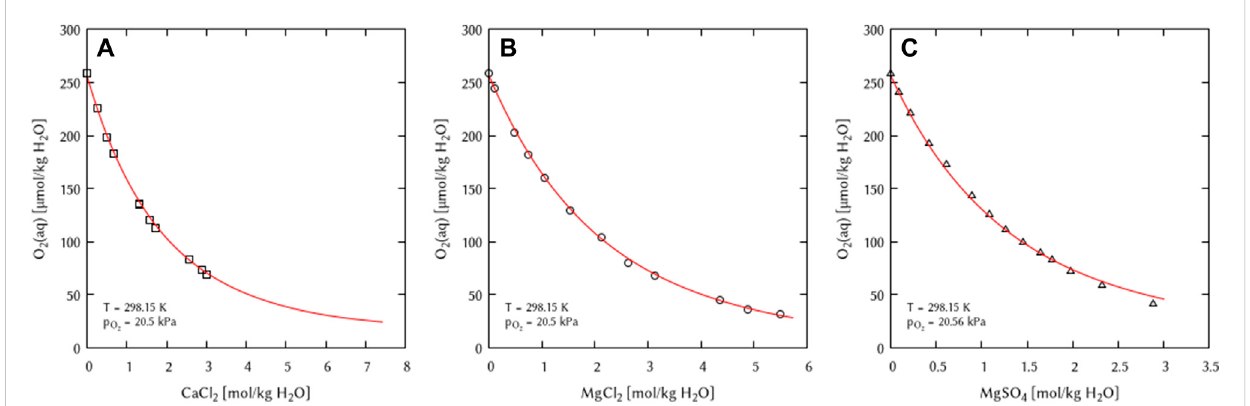
FIGURE 8 Modelling of the O 2 solubility in binary solutions of (A) CaCl 2 , (B) MgCl 2 , and (C) MgSO 4 as a function of electrolyte concentration at T = 298.15 K (Points: Experimental data from □ Millero et al. (2003), ○ Millero et al. (2002a), n Millero et al. (2002b) Lines: this work).